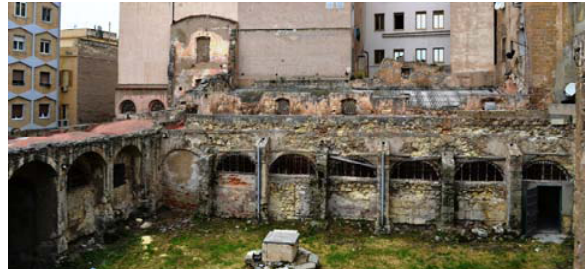
Figure 2: The buildings facing the cloister as seen from the north-east